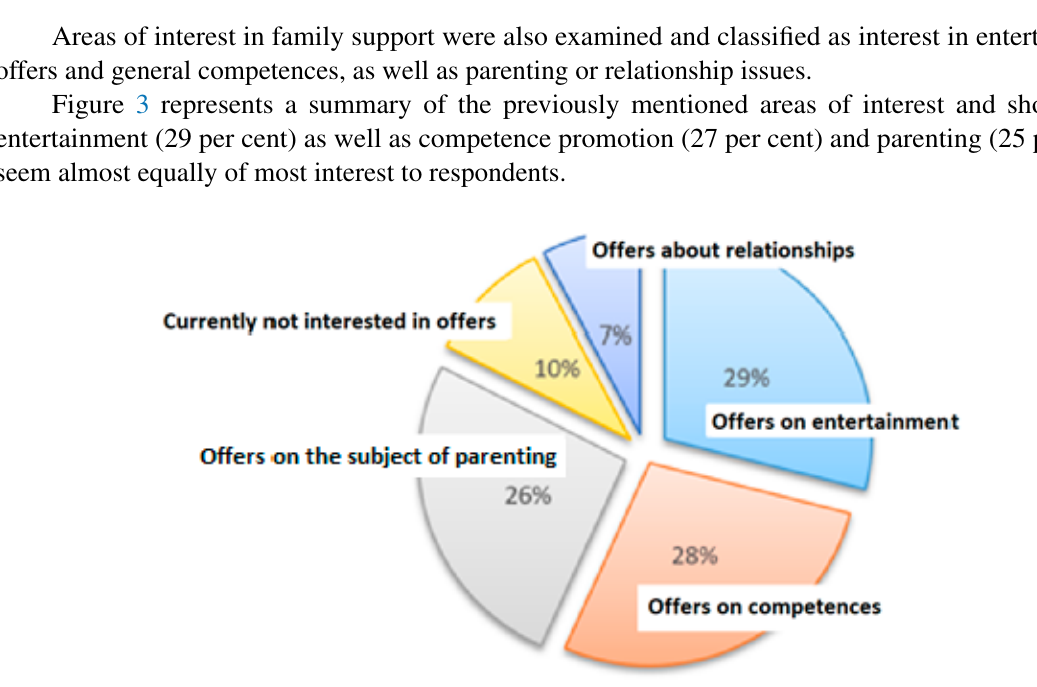
Figure 3. Areas of interest in family support (percentage data). (Source: Authors,